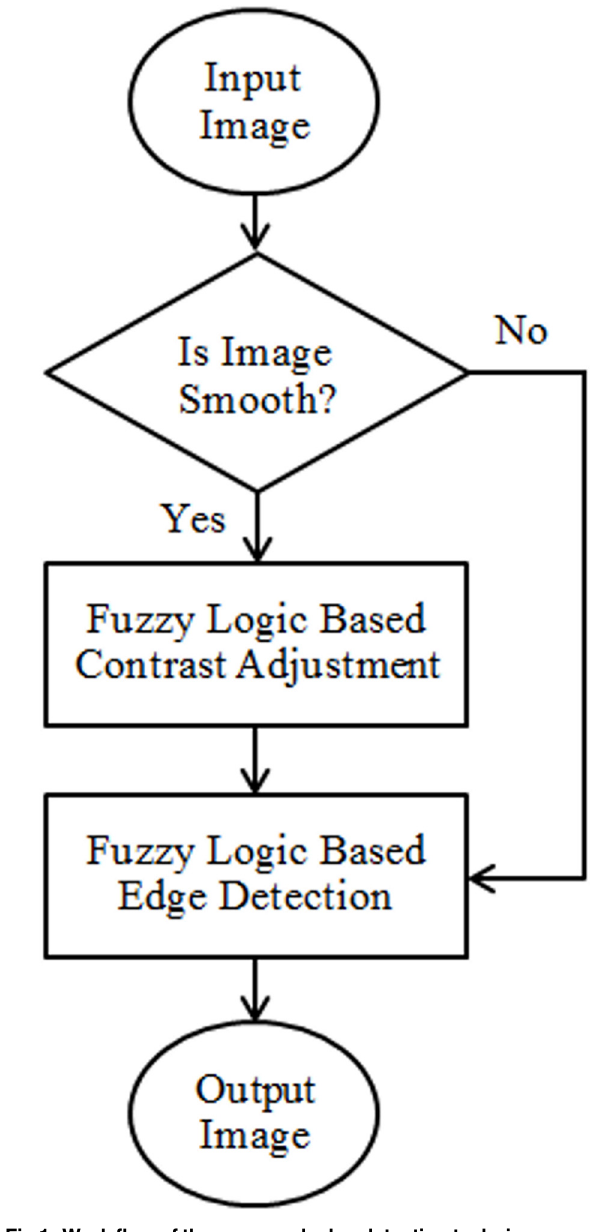
Fig 1. Work flow of the proposed edge detection